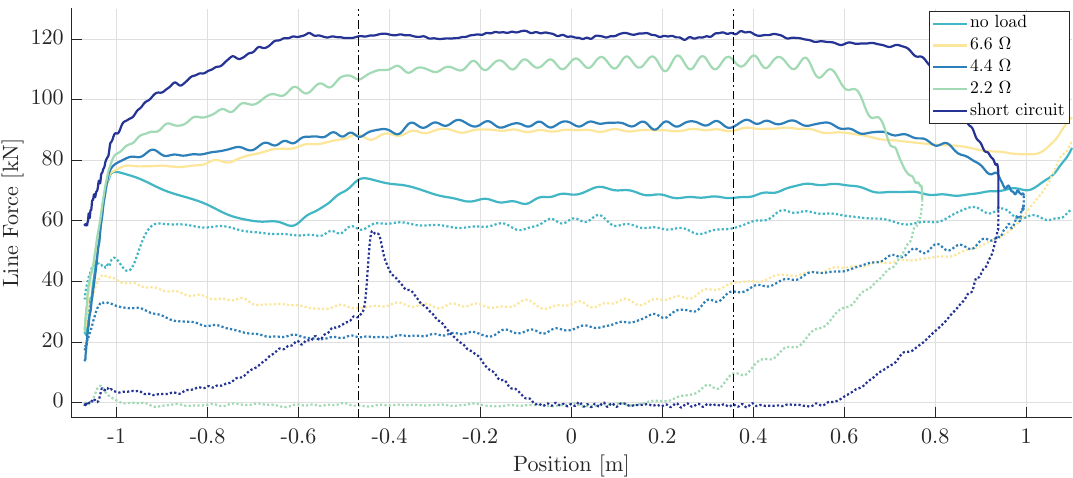
Figure 6. Line force in position domain for the high speed tests. Upward motion is represented with solid lines and downward motion is represented with dotted lines. The full active area is marked by vertical dotted